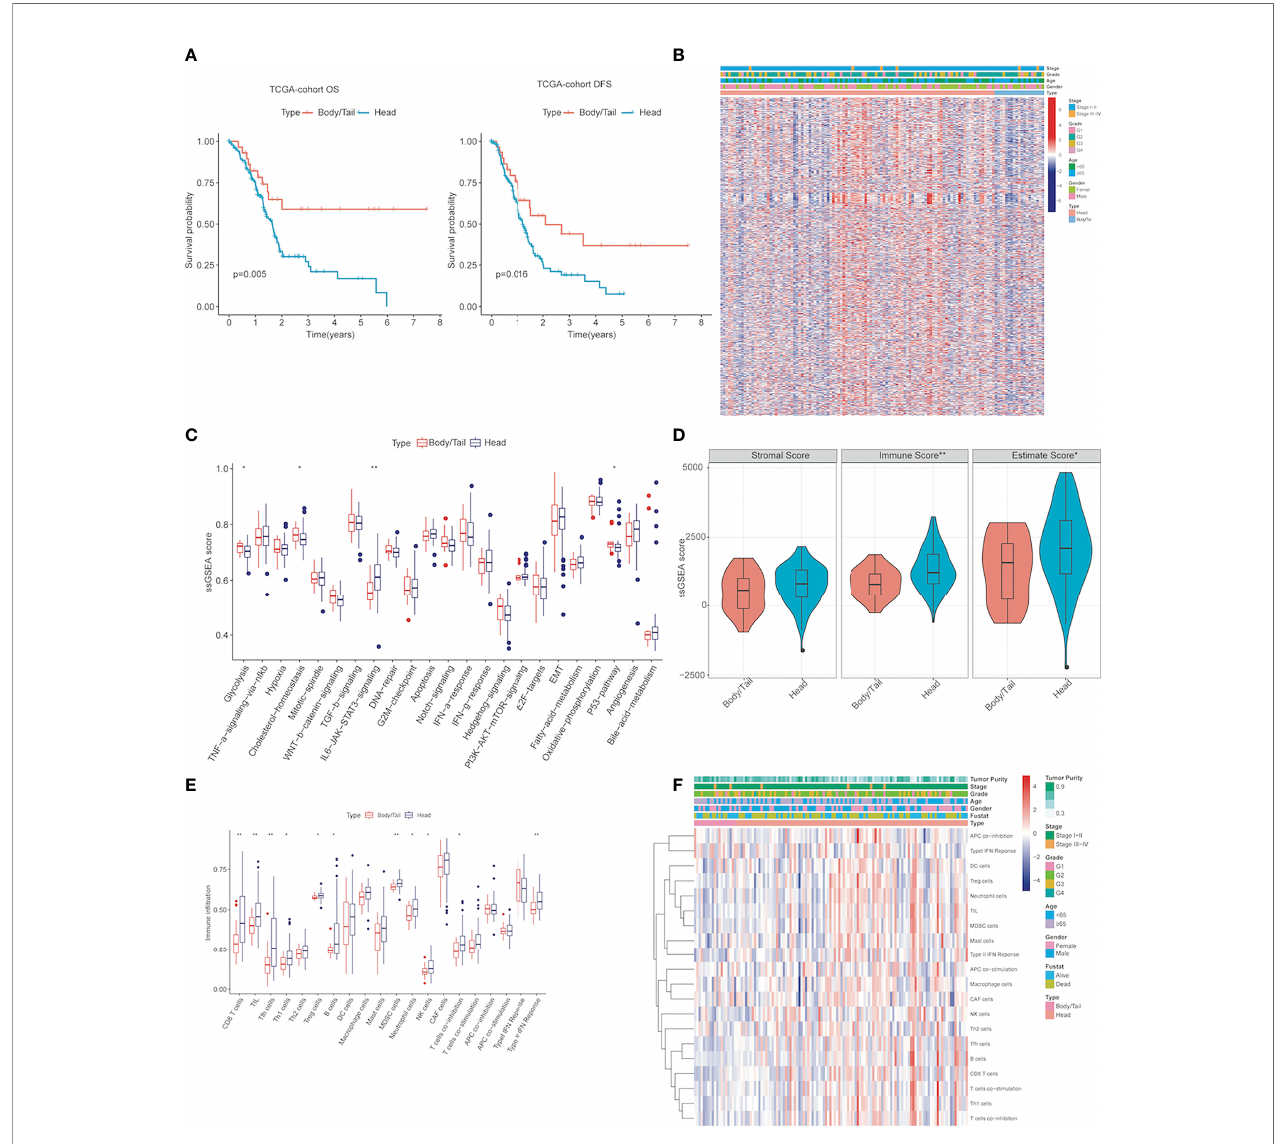
FIGURE 2 | The activity changes of immune microenvironment and hallmark pathway in pancreatic head cancer and pancreatic body/tail cancer were identi fi ed (A) Kaplan – Meier survival analysis of the head and body/tail of pancreatic cancers patients ’ OS and DFS in the TCGA validation cohorts. (B) Heatmaps of the upregulated and DEGs downregulated DEGs between pancreatic head cancer and pancreatic body/tail cancer in TCGA. (C) ssGSEA analysis demonstrated that various cancer hallmarks exhibited signi fi cantly higher activity in pancreatic head cancer group compared with pancreatic body/tail cancer group. (D) pancreatic head cancer was characterized with signi fi cantly higher immune score. (E) Most of the 20 immune cell types were differentially distributed between the two groups. (F) A comprehensive heatmap illustrated the differences of the immune in fi ltration of the tumor microenvironment between the two groups. ssGSEA, single-sample gene set enrichment analysis; **p < 0.01, *p < 0.05 and not signi fi cant (p < 0.05) by repeated measures with Wilcoxon